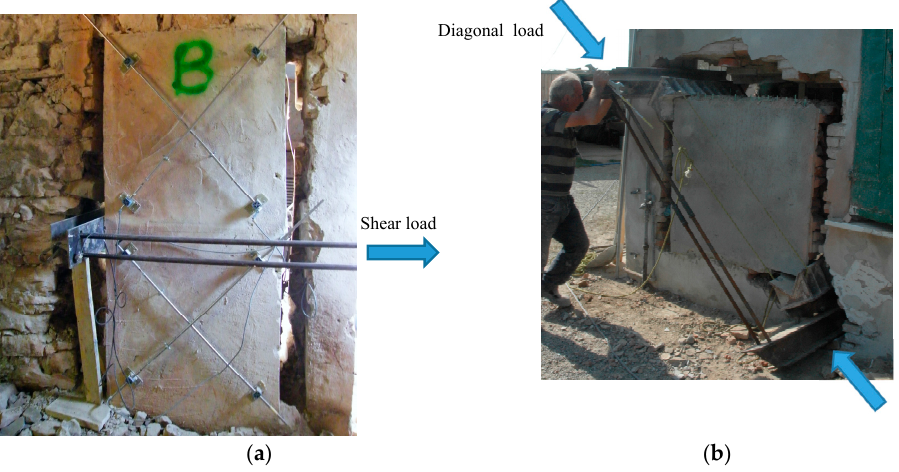
Figure 2. ( a ) Shear compression test; ( b ) diagonal compression test.